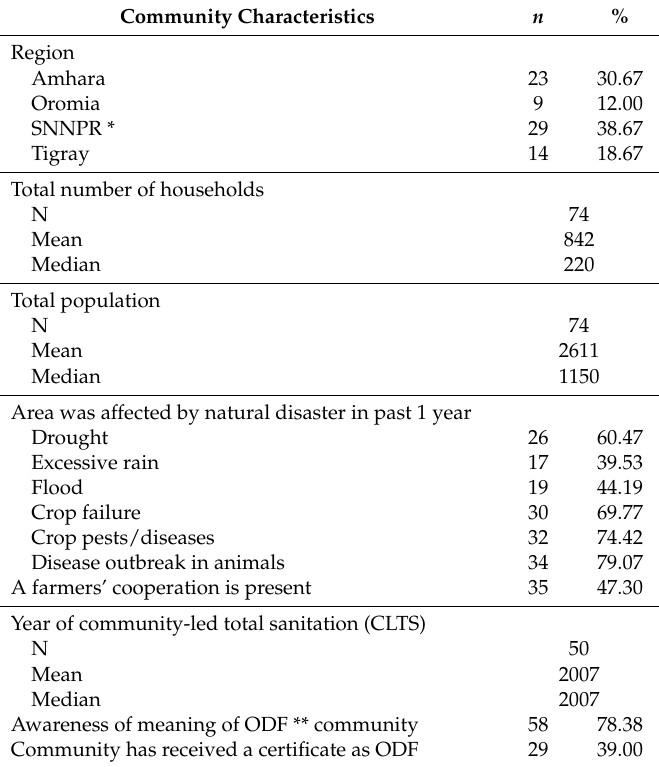
Table 1. Characterization of